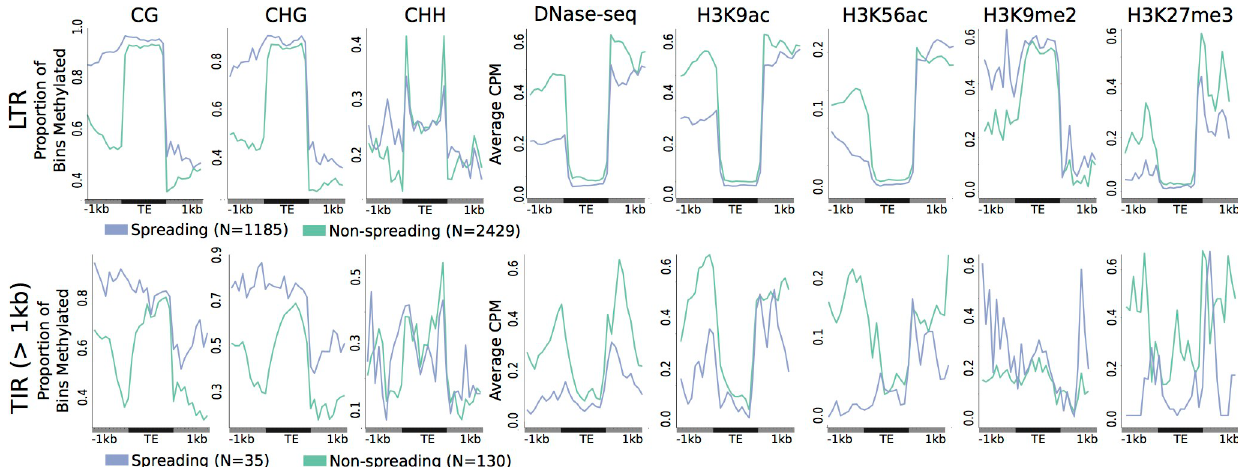
Fig 8. Chromatin profiles at elements with or without spreading of DNA methylation. For LTR or TIR elements that are inserted into CG unmethylated empty sites we assessed the chromatin profiles based on the proportion of bins methylated ( > 40% for CG/CHG and > 2% for CHH) or average CPM (ChIP-seq and DNase-seq) for elements with spreading (purple) or without spreading (green) of DNA methylation in B73. Elements are oriented with the highest average level of methylation on the left. Number of elements in each group is indicated next to the key.